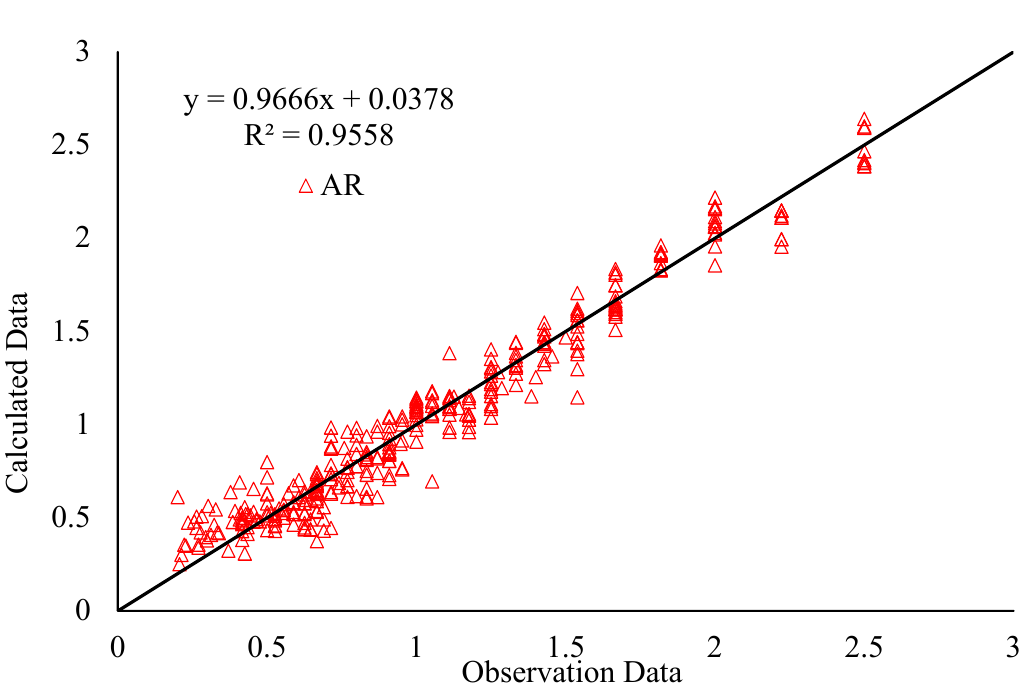
Figure 11. Predicted vs. experimental values of the AR output for the PCA-ABC-ANN model using training data.